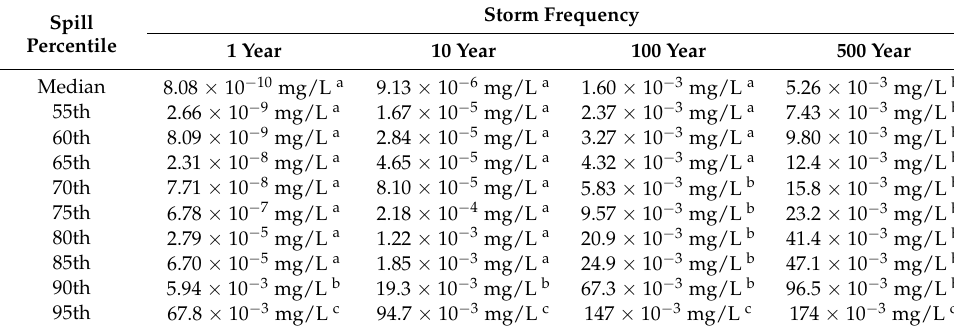
Figure 6. Benzene concentration breakthrough curves accounting for degradation and sorption for a 2 ft water table and the 500 year storm on a log–log scale. Each curve represents a different spill percentile with warmer colors representing larger spill sizes and cooler colors indicating smaller spill sizes. Table 5. Peak concentrations predicted for produced water spill and storm simulations considering a 2 ft groundwater table, accounting for degradation and